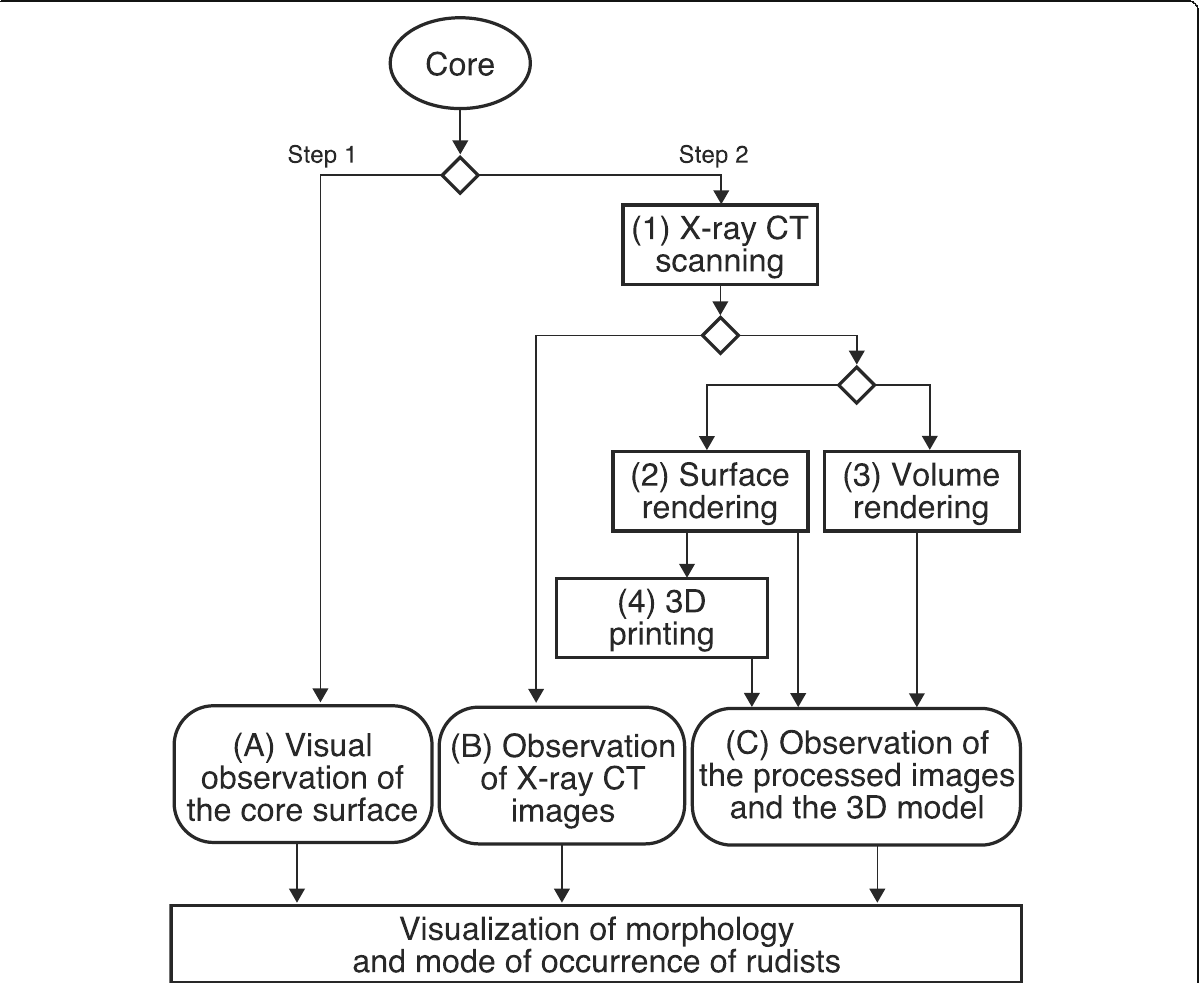
Fig. 3 Flow chart of the X-ray CT image analysis conducted in the present study.Two steps of image analysis were conducted for rudists in the studied core. Step 1 was visual observation of rudists at the core surface (A). Step 2 included direct observation (1, B) and processing of X-ray CT images of rudists in the core interior. To understand rudist morphology and spatial configuration, two techniques were adopted for X-ray CT image processing: surface rendering (2) and volume rendering (3) (further details of the surface rendering and volume rendering are provided in Additional file 1: Document S1). From the results of the surface rendering, one 3D-printed model was made (4). By integrating all results, we visualized the morphology and mode of occurrence of the